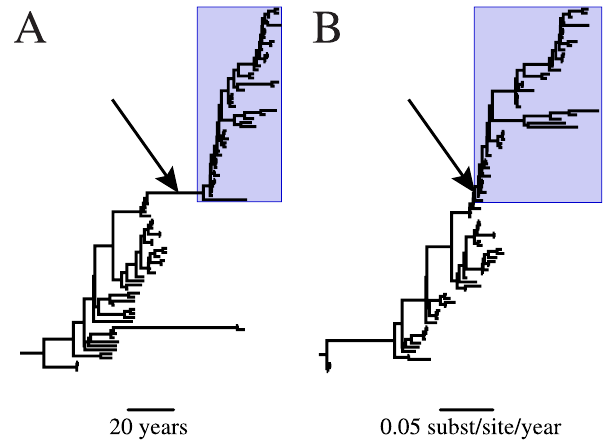
Figure 1. Maximum clade credibility phylogeny of human H1N1 influenza virus HA segment with unadjusted sampling dates. The topologies of (A) a chronogram in which branch lengths represent time and (B) a phylogram in which branch lengths represent nucleotide substitutions are identical. Avian and swine influenza virus lineages were removed for ease of viewing. Arrows indicate the lineage leading to the re-emergent HIN1 clade; boxes designate the re- emergent H1N1 clade.